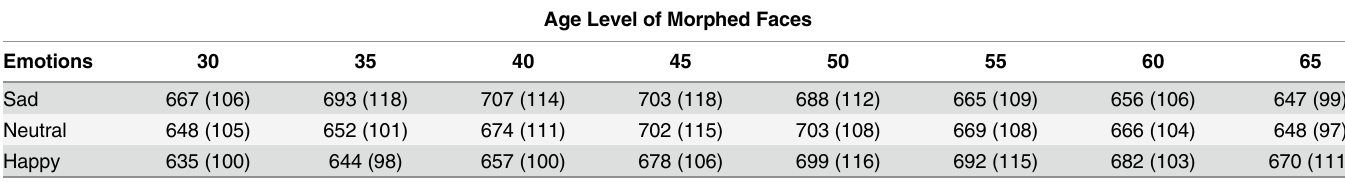
Table 2. Means and standard deviations of response times in millisecond.